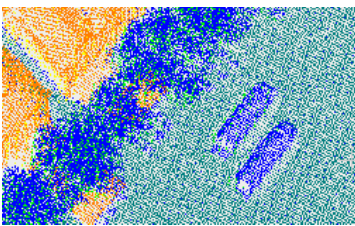
Figure 6. Google Streetview (left) and 3D Tree (right)